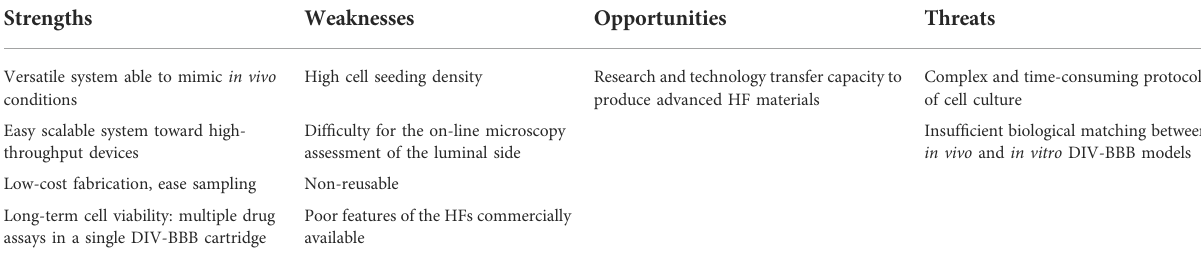
TABLE 3 Summary of the SWOT analysis to get DIV-BBB systems as commercial